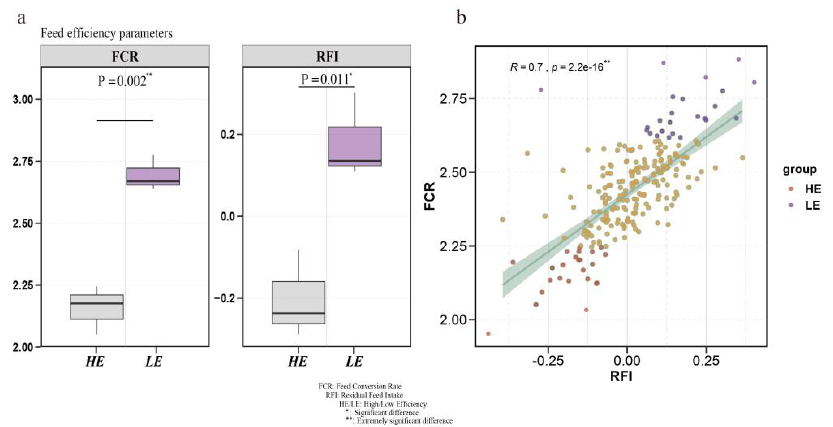
Figure 1. Statistics results and analysis of feed efficiency (FE)-related phenotypes. ( a ) The feed conversion ratio (FCR) and residual feed intake (RFI) between high- and low-FE groups. ( b ) Correlation analysis of RFI and FCR related to feed efficiency in 225 pigs.